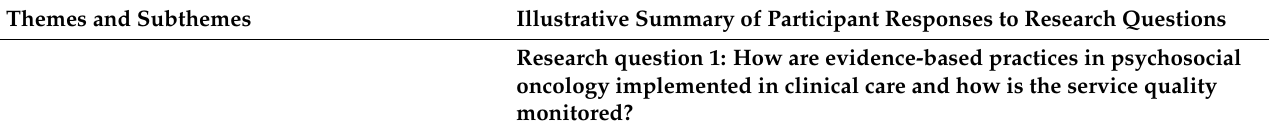
Table 2. Overview of themes and subthemes identified for each research